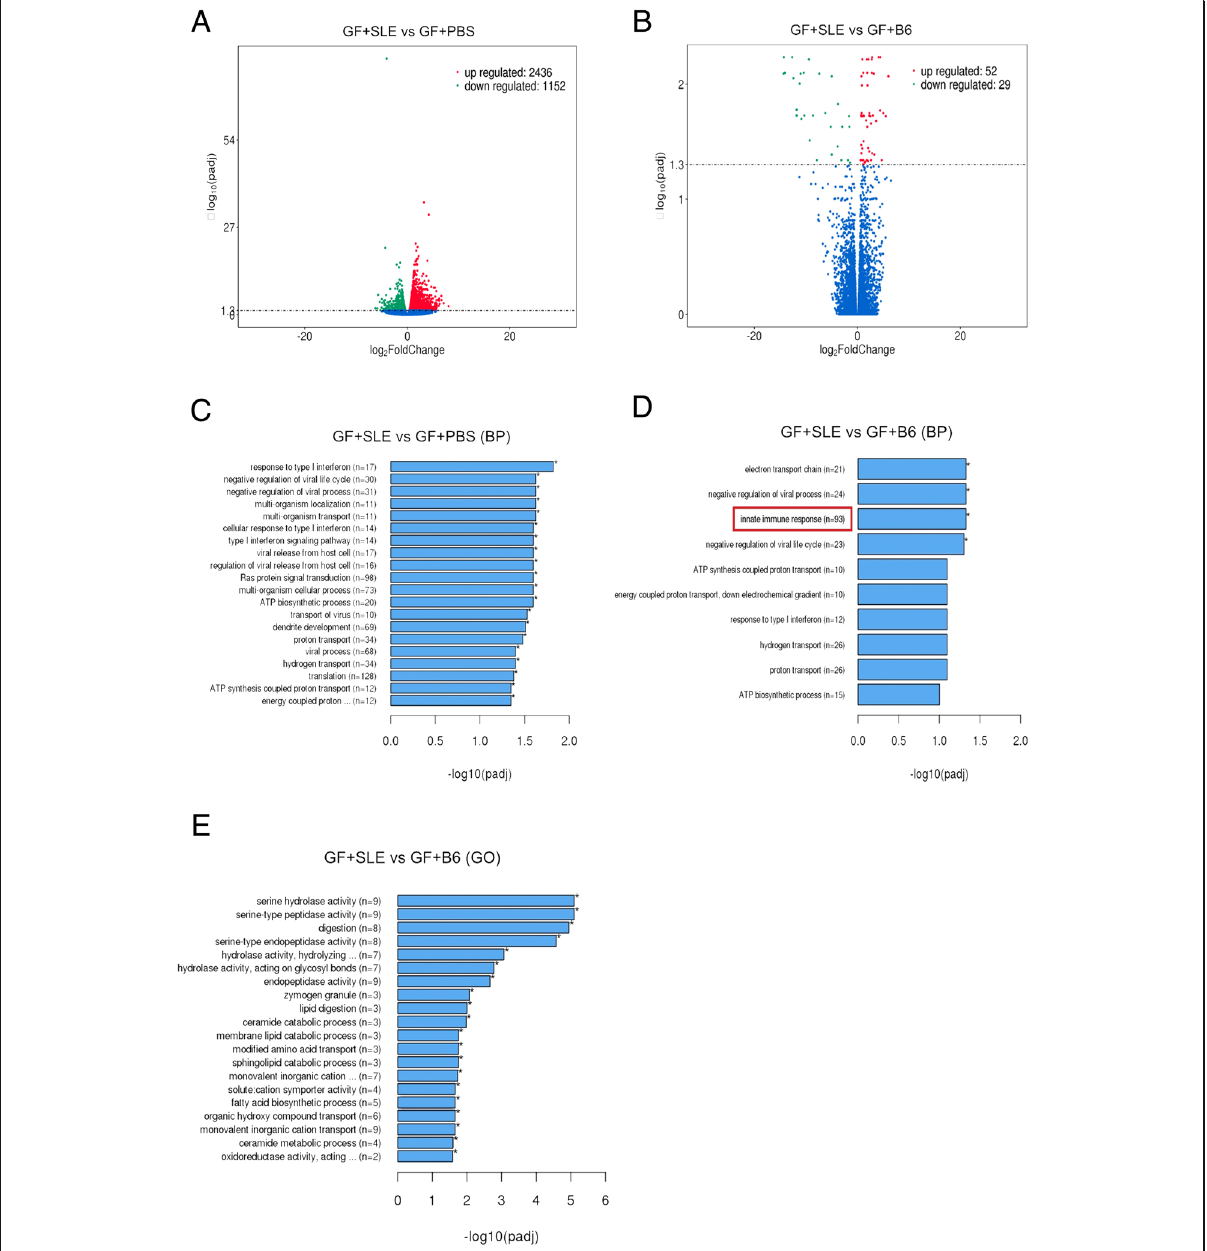
Fig. 5 Differential expression of genes (DEGs) in the intestines of GF mice after different treatments. (A) Comparison of the GF + SLE and the GF + PBS groups. (B) Comparison of the GF + SLE and GF + B6 groups. (C) Biological process enrichment of the GF + SLE group relative to the GF + PBS group. (D) Biological process enrichment of the GF + SLE group relative to the GF + B6 group. (E) Gene ortholog (GO) enrichment of the GF + SLE group relative to the GF + B6 group. * beside the bar represents significant difference between